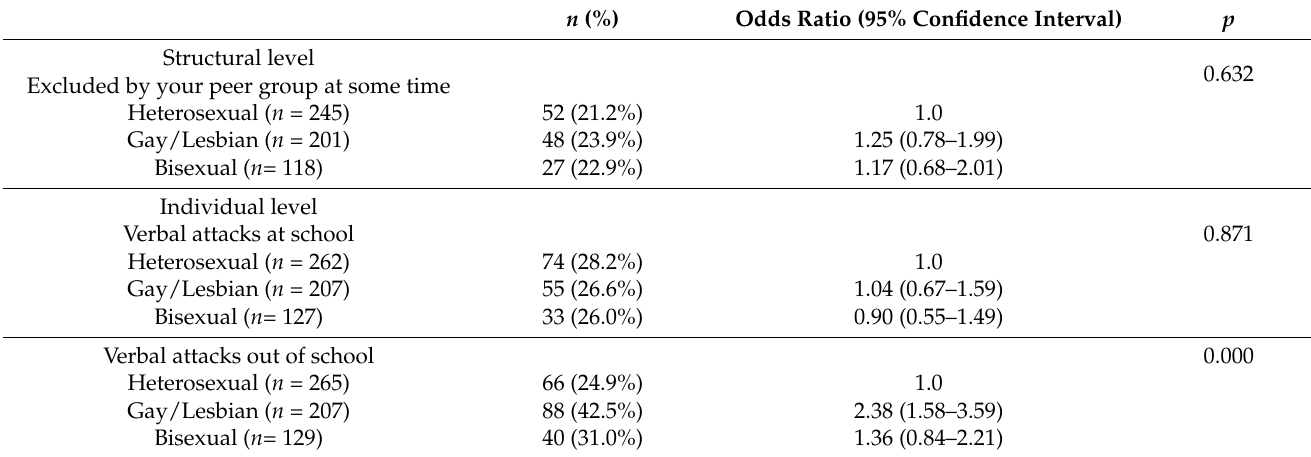
Table 2. Associations between sexual orientation and individual and structural